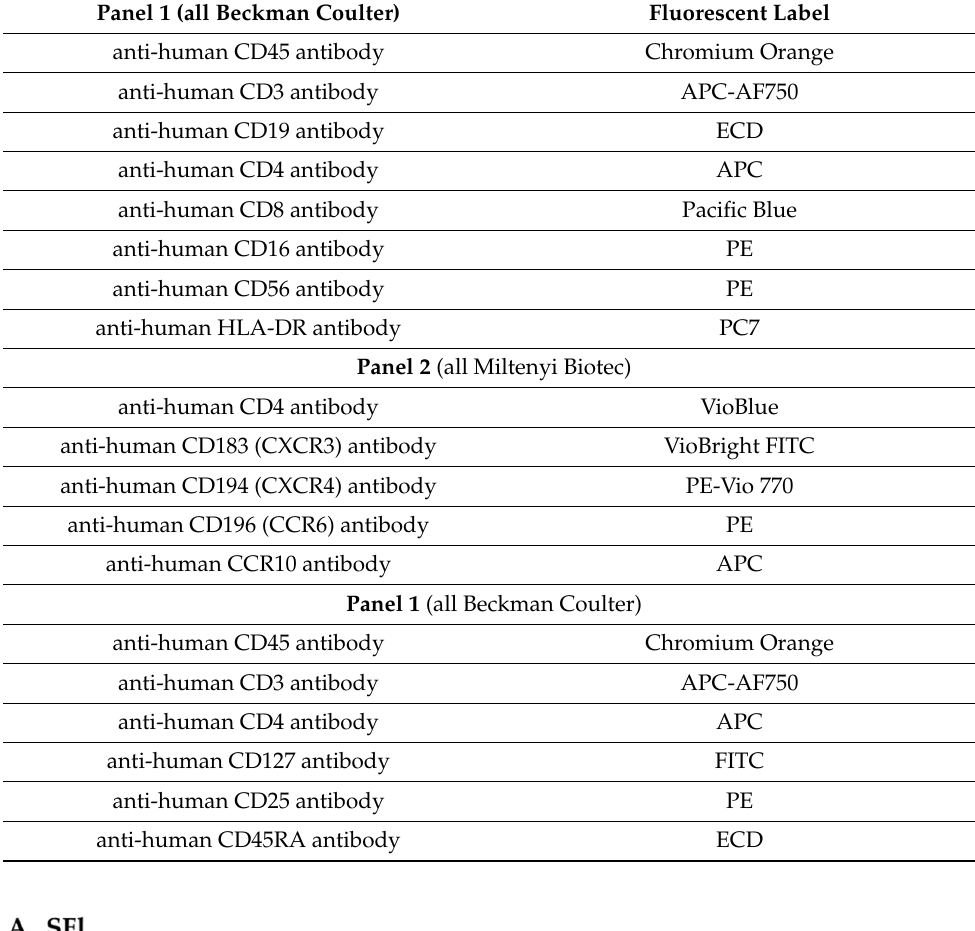
Table 2. Description of antibody panels used for flow cytometry analysis.